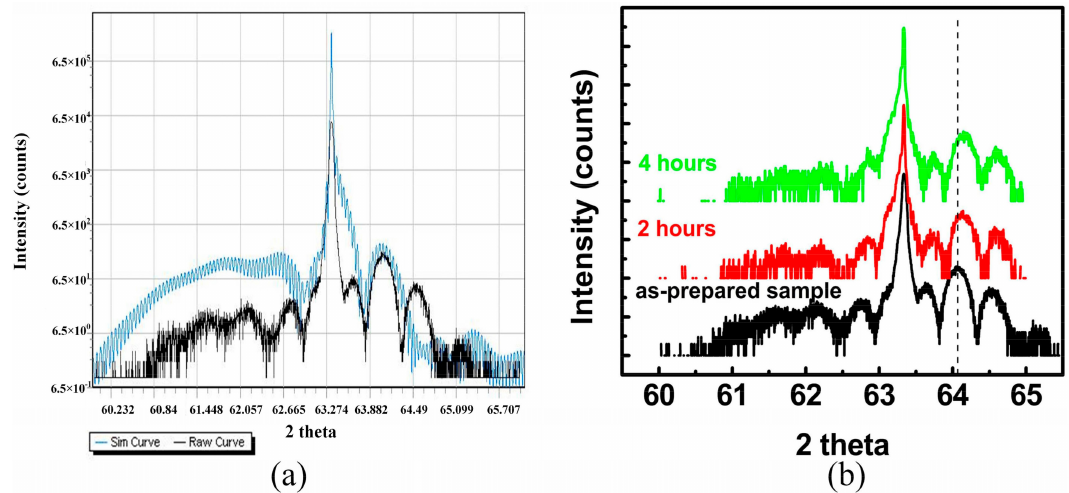
Figure 2. ( a ) Diffraction pattern of the sample as grown compared with a simulated curve. The blue curve is the simulation of the sample as grown. ( b ) Intensity (counts)-2 θ scans of high-resolution X-ray diffraction (HR-XRD) patterns of Al 0.07 Ga 0.22 In 0.71 As QW thermally treated at 170 ◦ C with different